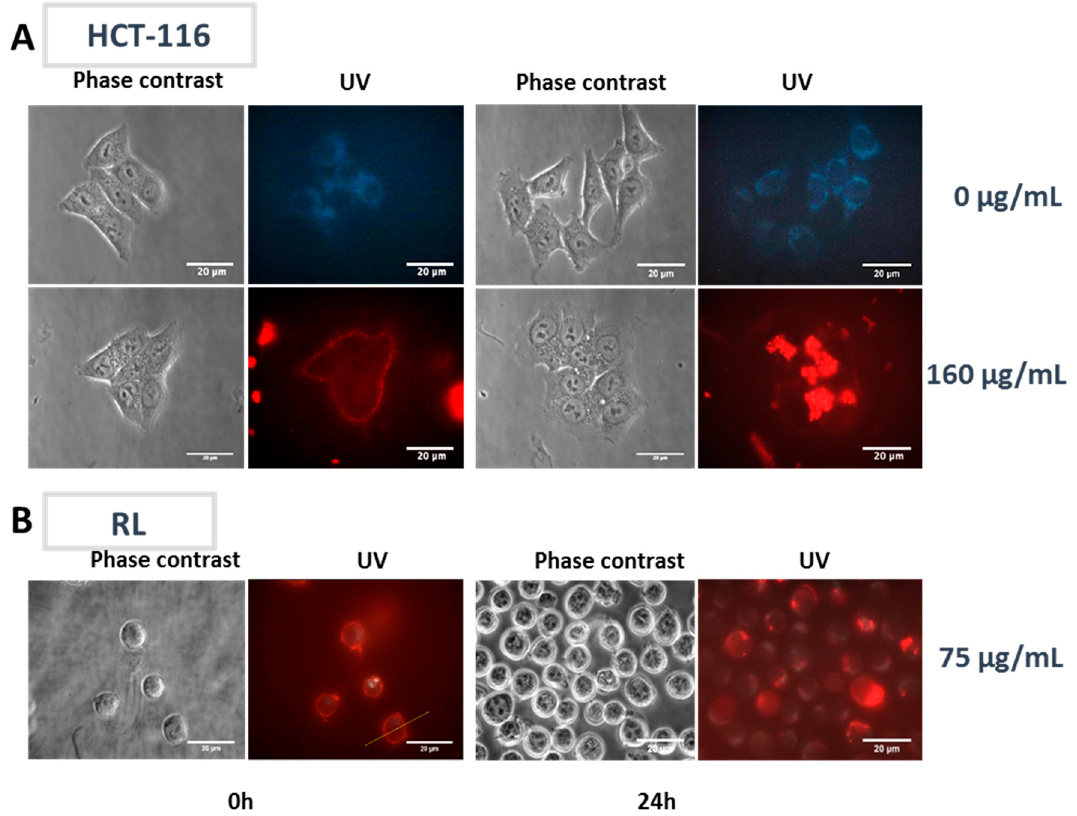
Figure 3. Visualization of HCT-116 and RL cells in the presence of LumiLys 650 NPs. HCT-116 and RL cells were incubated with or without LumiLys 650 NPs in the culture medium and visualized by wide field fluorescence microscopy (63 × magnification). After 24 h of incubation, cells were first imaged by phase contrast and then by UV excitation using a UV filter ( λ exc : 340–380 nm, λ em : 425 nm long-pass filter). Under UV excitation, cell autofluorescence appeared in blue while SiNPs’ fluorescence appeared in red. ( A ) HCT-116 were incubated with or without LumiLys 650 NPs (at 160 µ g/mL) and ( B ) RL cells (at 75 µ g/mL) in the culture medium.